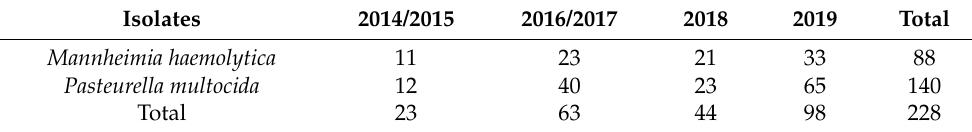
Table 1. Major bovine respiratory disease isolates obtained in the 2014–2019 collection period.